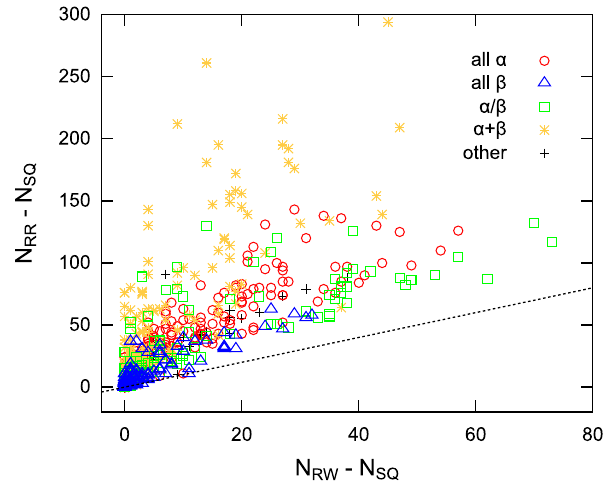
Figure 7. Scatter plots showing N RW { N SQ versus N RR { N SQ and N RW { N SQ versus N RR { N RW for all fold representatives. The colors of the plots represent the SCOP classes as follows: all- a (red), all- b (blue), a / b (green), a + b (yellow), and others (black). The break line represents the equation y ~ x . (A) and (B) respectively represent the scatter plots showing N RW { N SQ versus N RR { N SQ and N RW { N SQ versus N RR { N RW .